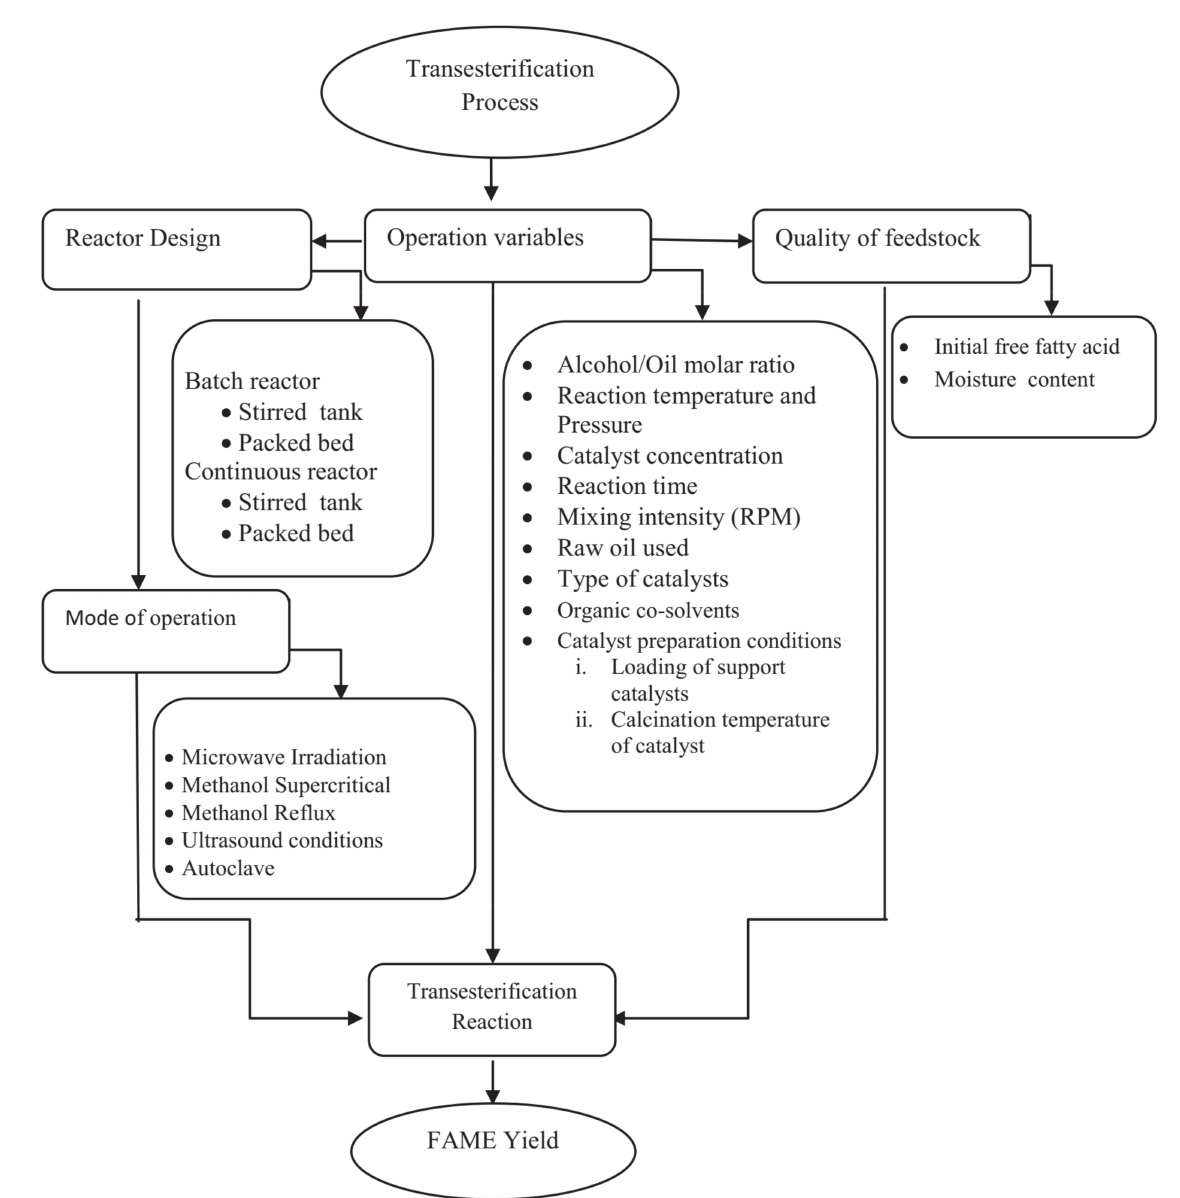
Figure 3. Process variables in transesterification reaction. Reproduced with permission from Islam et al., [Studies on design of heterogeneous catalysts for biodiesel production]; published by Elsevier, 2013